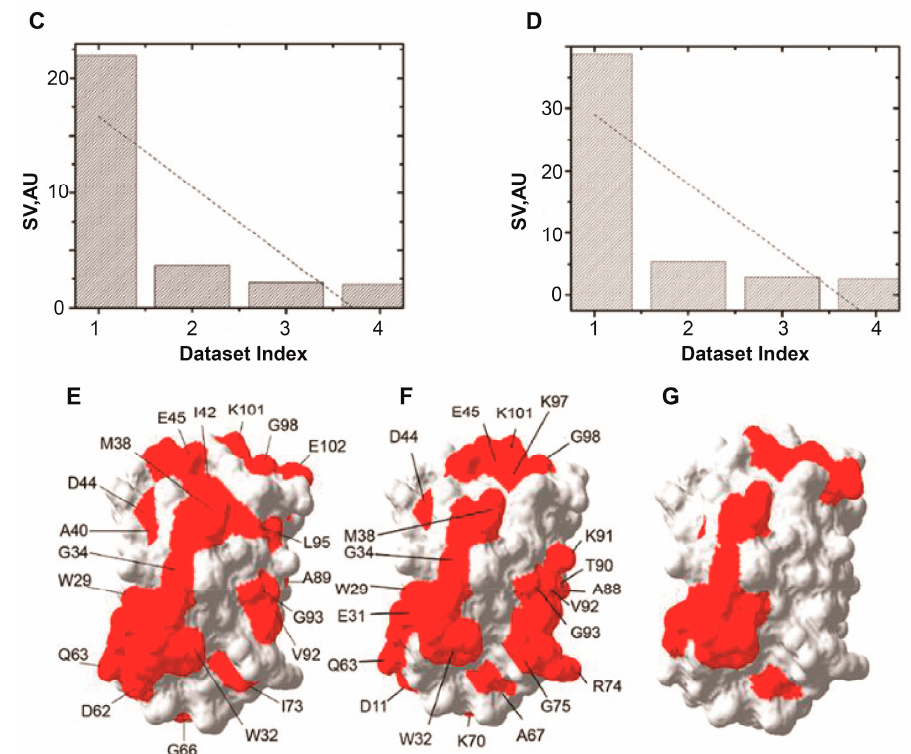
Figure 7. Binding of tetracycline and streptomycin to ribosomes changes the quinary structure of Trx in E. coli . ( A ) Overlay of the in-cell 1 H- 15 N CRINEPT–HMQC–TROSY spectra of [ U - 15 N] Trx without (red) and with (blue) tetracycline. ( B ) Overlay of the in-cell 1 H- 15 N CRINEPT–HMQC–TROSY spectra of [ U - 15 N] Trx without (red) and with (blue) streptomycin. Single and double asterisks indicate peaks from metabolites and unassigned side chain protons, respectively. The overlaid spectra are at the same contour levels. The reference peak used for peak intensity normalization is indicated by RP. ( C ) Distribution of singular values of each dataset index (binding mode) for Trx residues in the presence of tetracycline. ( D ) Distribution of singular values of each dataset index (binding mode) for Trx residues in the presence of streptomycin. ( E ) Residues involved in quinary interactions (red) due to the presence of tetracycline are mapped onto the molecular surface of Trx (Protein Data Bank entry 1X0B). ( F ) Residues involved in quinary interactions (red) due to the presence of streptomycin. ( G ) Quinary interaction surface (red) of Trx in the absence of antibiotics. Panels B–G are adapted from Breindel et al. (2017) [36] .